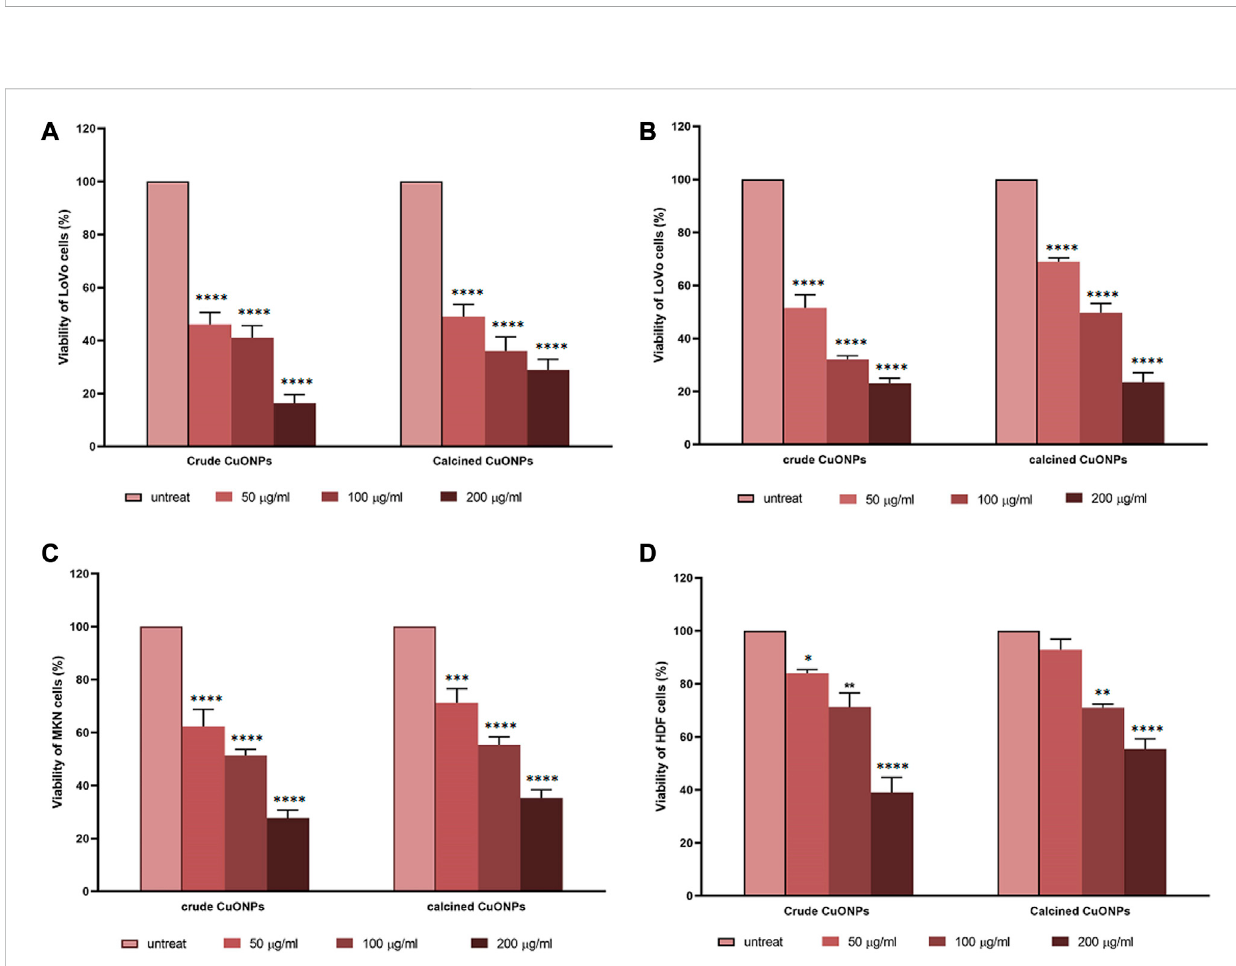
FIGURE 8 Dose-response curves representing the effects of crude and calcined CuONPs on viability of LoVo cells in normoxic (A) and hypoxic conditions (B) , MKN-45 cells (C) , andHDFcells (D) . Results areshown as mean± SD.* p < 0.05, ** p < 0.01*** p < 0.001 and**** p < 0.0001indicate signi fi cant difference with untreated